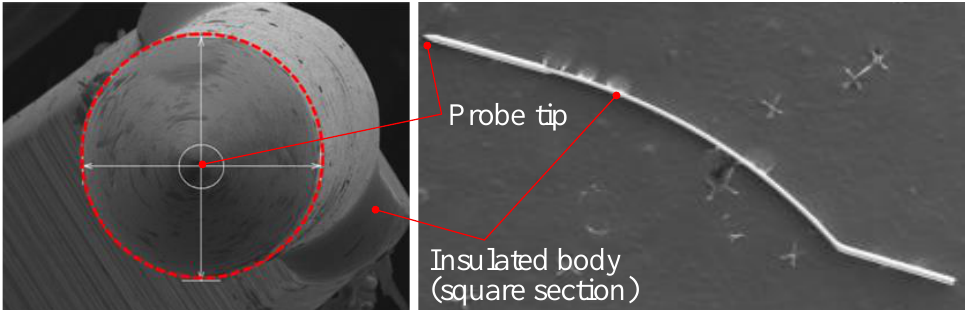
Figure 16. Shape of the probe card pin after press forming.